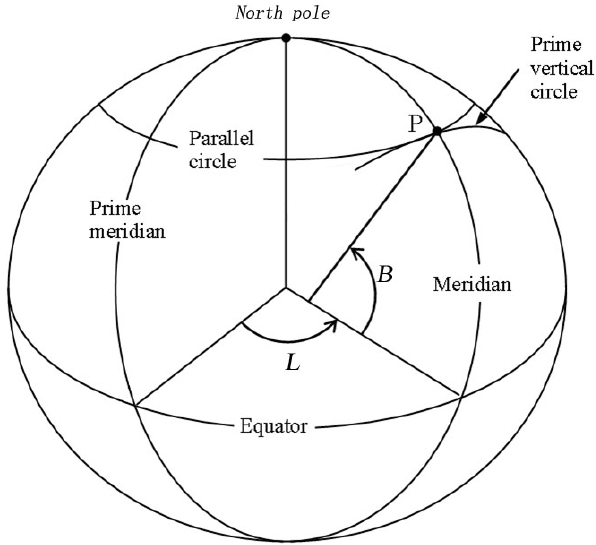
Fig. 1. The oblate spheroidal Earth geometry. B is geodetic latitude, L is longitude of a point P on the oblate spheroidal Earth